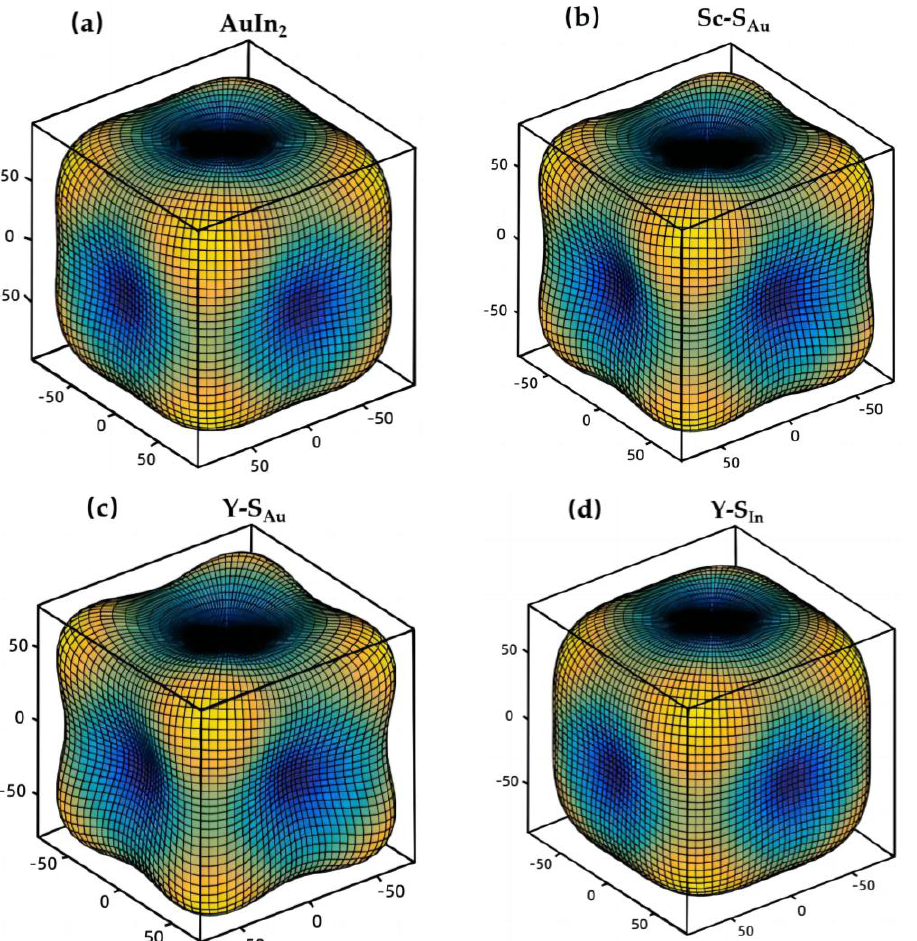
Figure 6. Three −dimensional surface structures of Young’s modulus of AuIn 2 and RE doped models. Figure 6. Three − dimensional surface structures of Young’s modulus of AuIn 2 and RE doped For all the graphs, the units are GPa.